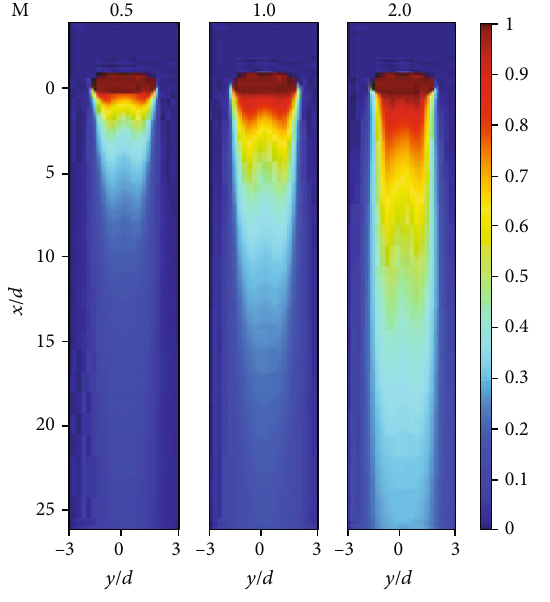
Figure 16: CFD contours of θ = 21 ° .